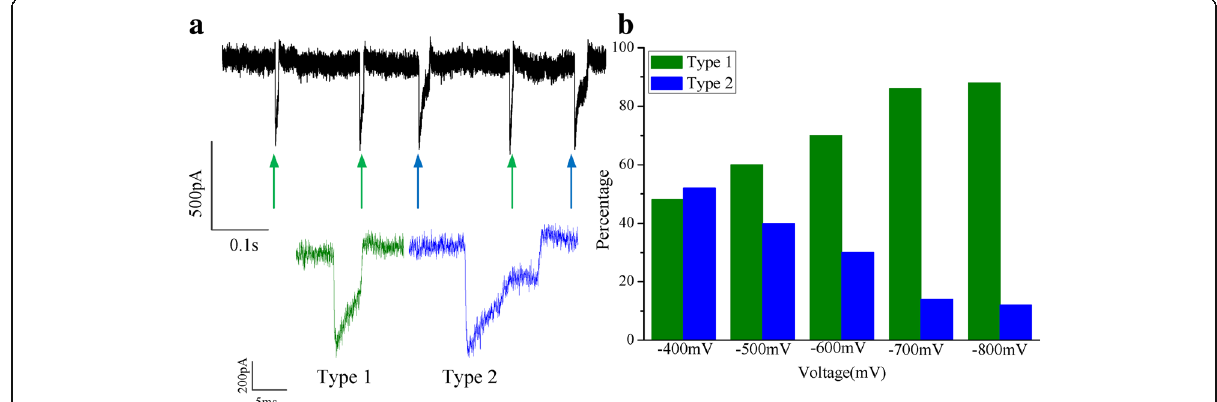
Fig. 7 a Schematic of two type translocation events at − 700 mV voltage. b The percentage of two types events at different voltages ( − 400, − 500, − 600, − 700, − 800